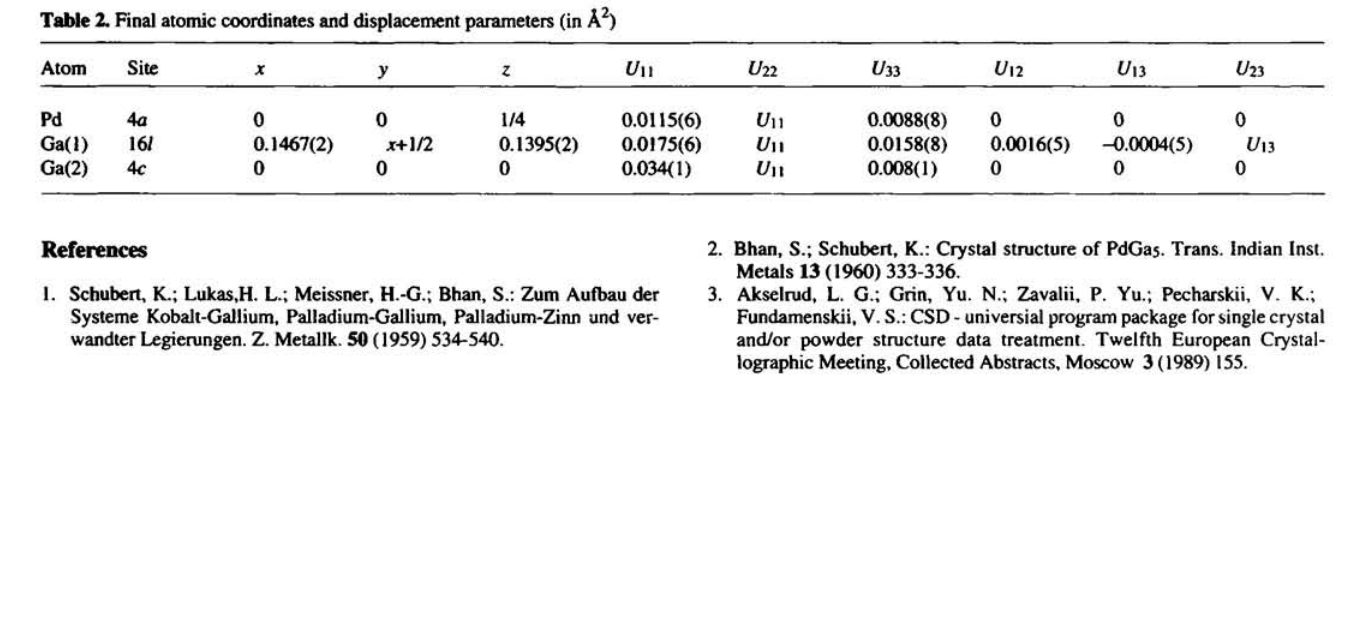
Table 2. Final atomic coordinates and displacement parameters (in Â 2 )